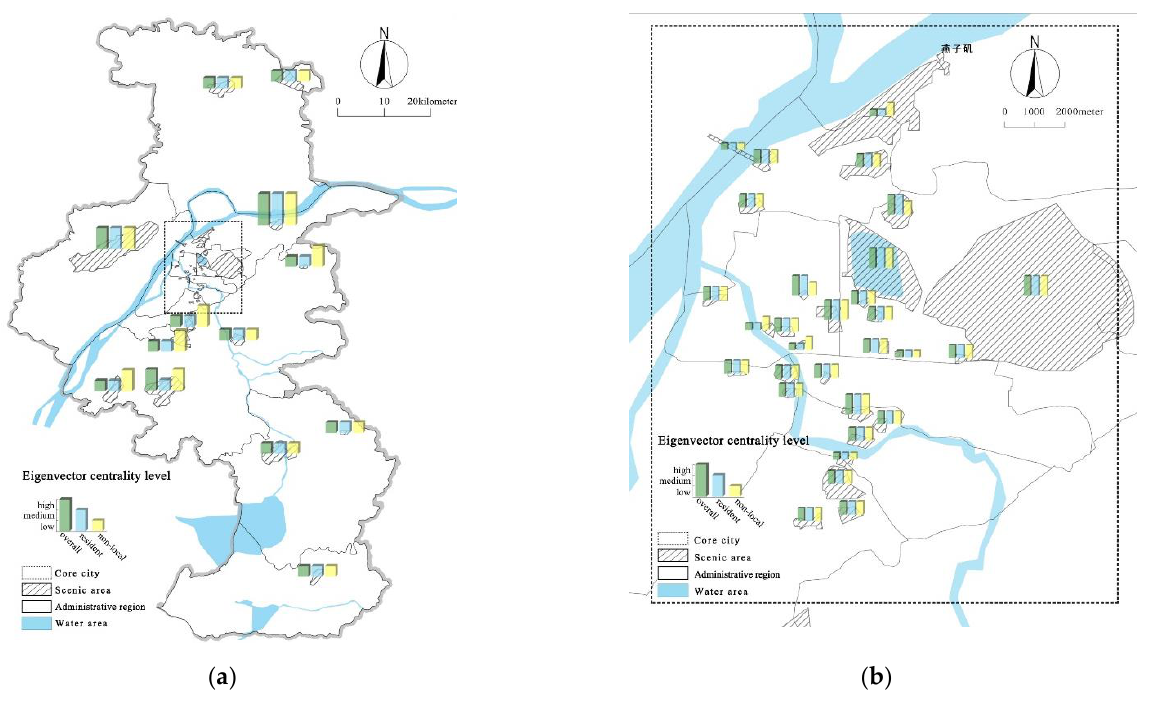
Figure 6. Classification map of the eigenvector centrality of nodes under three types of network context (overall, resident, and non-local tourist): ( a ) entire city of Nanjing; ( b ) core city of Nanjing.